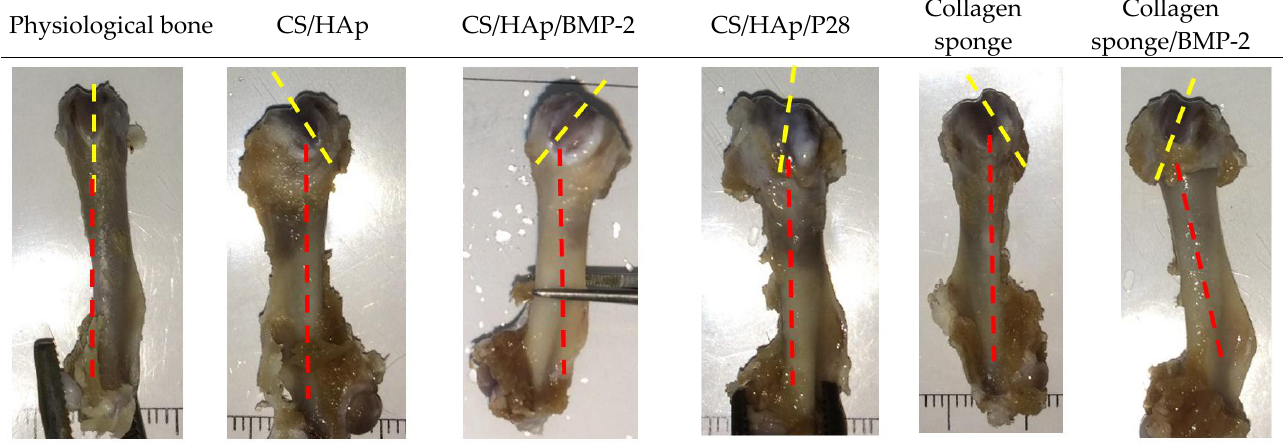
Figure 7. Representative images of twisted condyles comparisons between the implanted and phys- iological femoral condyle after eight weeks, showing that all groups experienced twisted condyle formation that might be caused by rotational instability from the defect induction and implantation. Annotations: Yellow broken lines = condyle axis; Red broken lines= femoral diaphysis axis